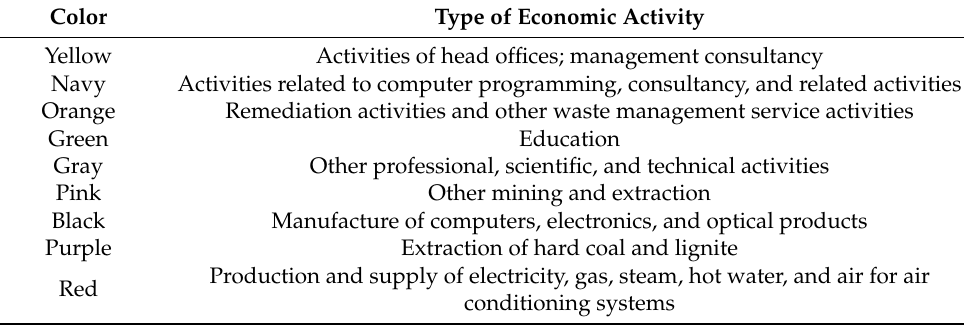
Table 1. Explanation of the colors used in the conducted